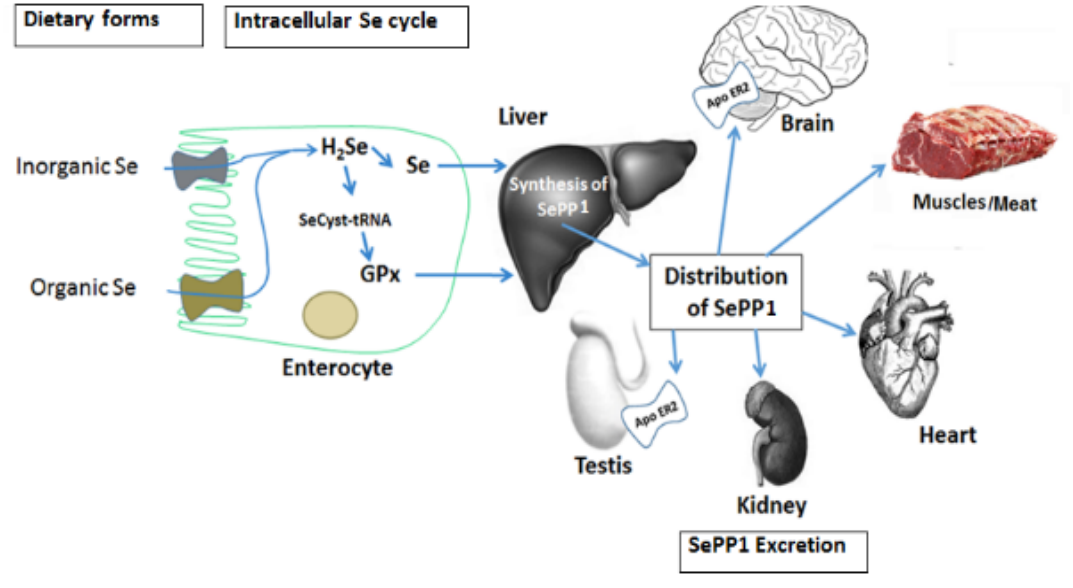
Figure 1. General pathways of Se absorption, hepatic synthesis of SePP1 and distribution to various organs. Adapted from Kumar and Priyadarsini